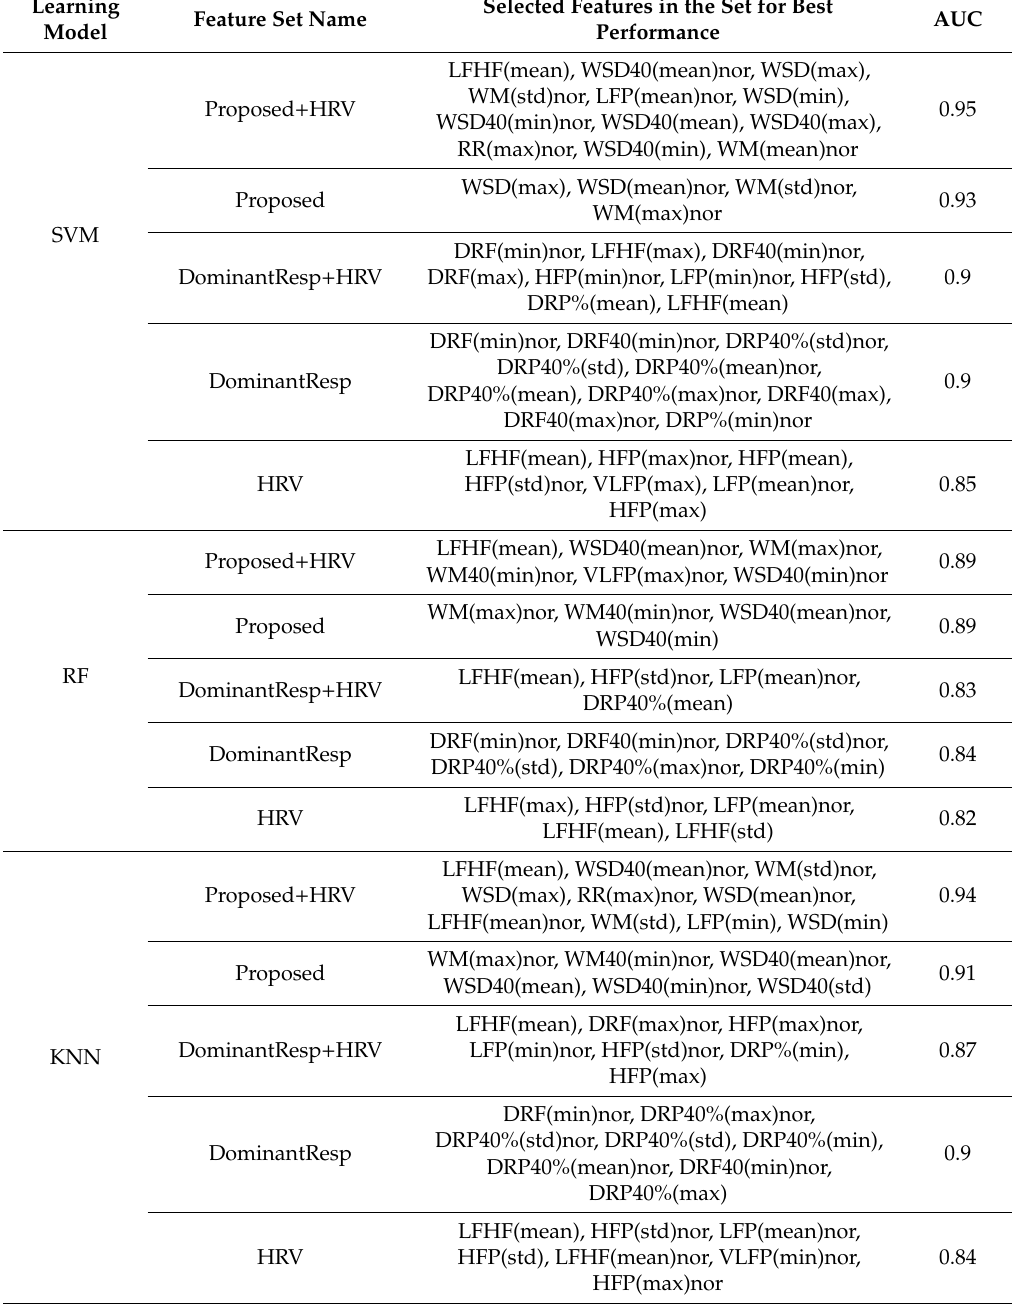
Table 2. A list of selected features (using the greedy feed forward selection method) in each feature set for prediction. In each feature set, the chosen features are given in the order of significance. (Notation ended with ‘nor’ indicates that it is a normalized